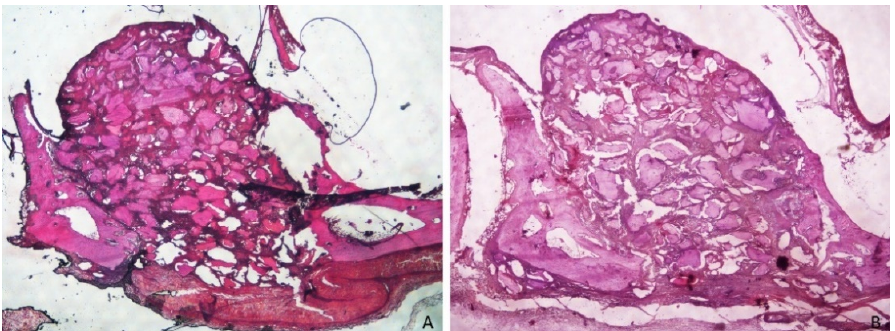
Figure 3. ( A ) Merged images from photomicrographs of sections of decalcified samples representing the healing after 2 weeks in the membrane group. Scarlet-acid fuchsine and toluidine blue. ( B ) Merged images from photomicrographs of sections of decalcified samples representing the healing after 2 weeks the in non-membrane group. Scarlet-acid fuchsine and toluidine blue.